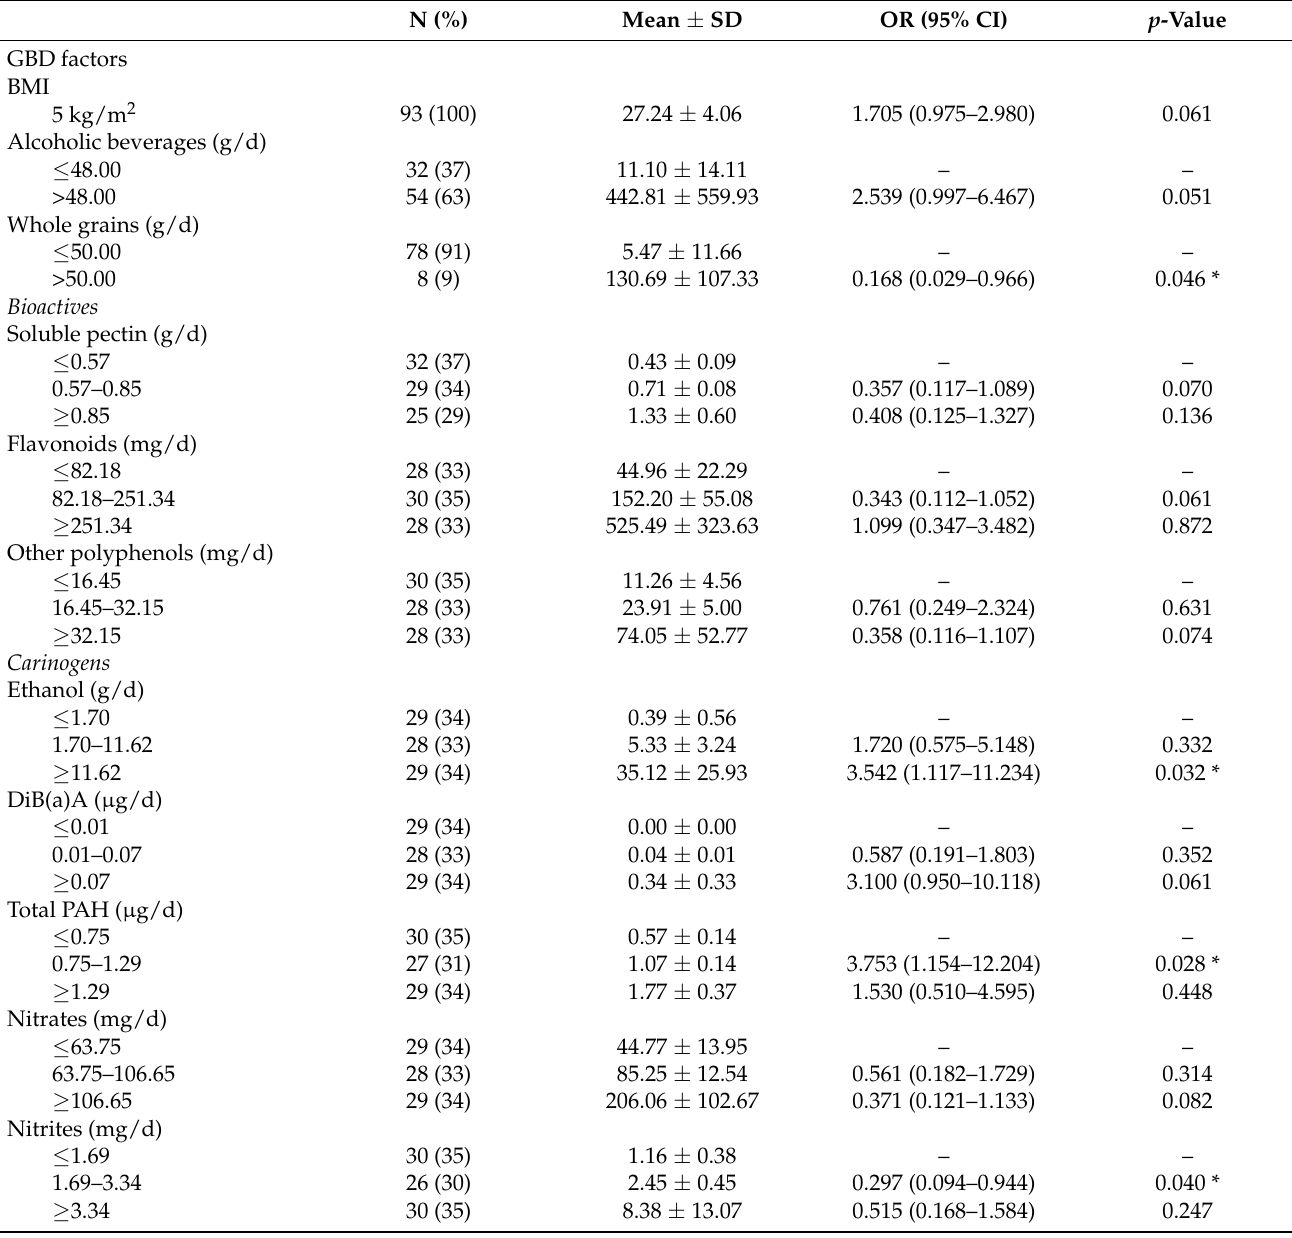
Table 3. GBD risk-related factors, bioactive and carcinogen tertiles as predictors of polyp